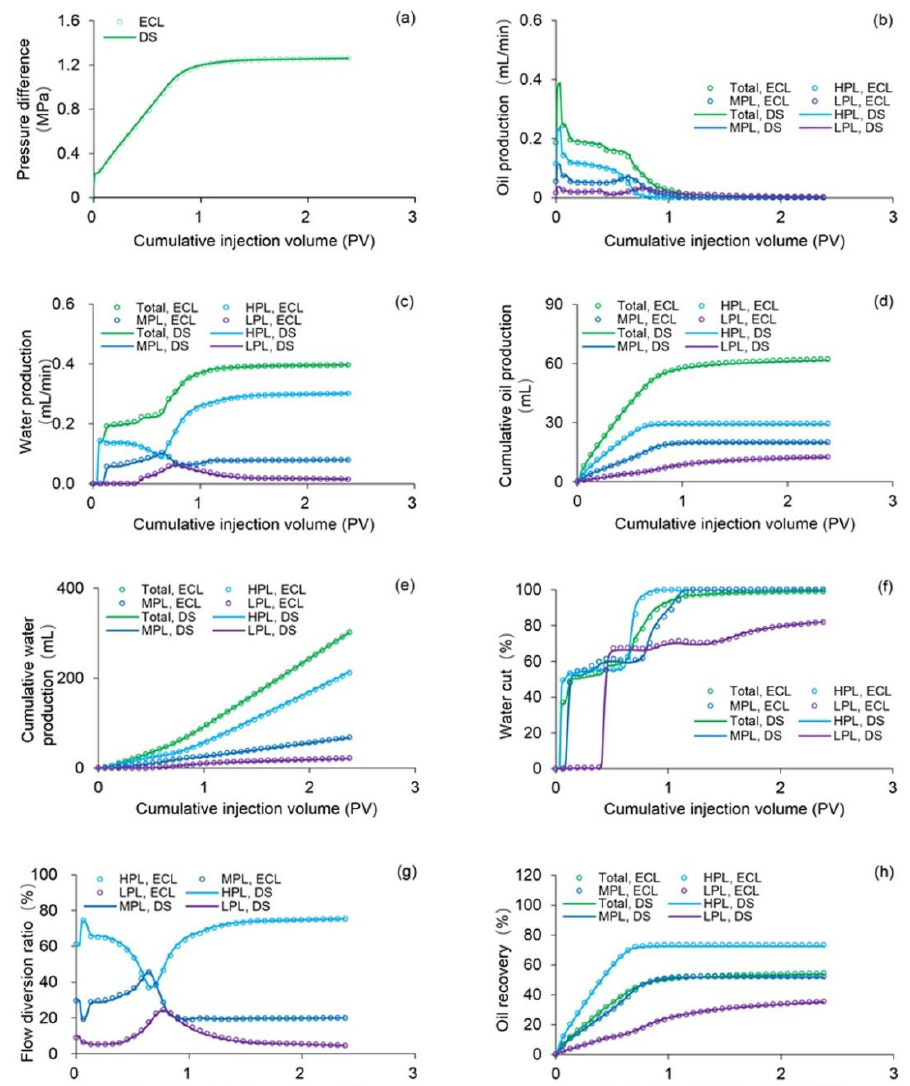
Figure 10. Comparison results of ( a ) pressure difference, ( b ) oil production, ( c ) water production, ( d ) cumulative oil production, ( e ) cumulative water production, ( f ) water cut, ( g ) flow diversion ratio and ( h ) oil recovery of Case 1 simulated by the ECLIPSE V2013.1 software and the designed simulator.